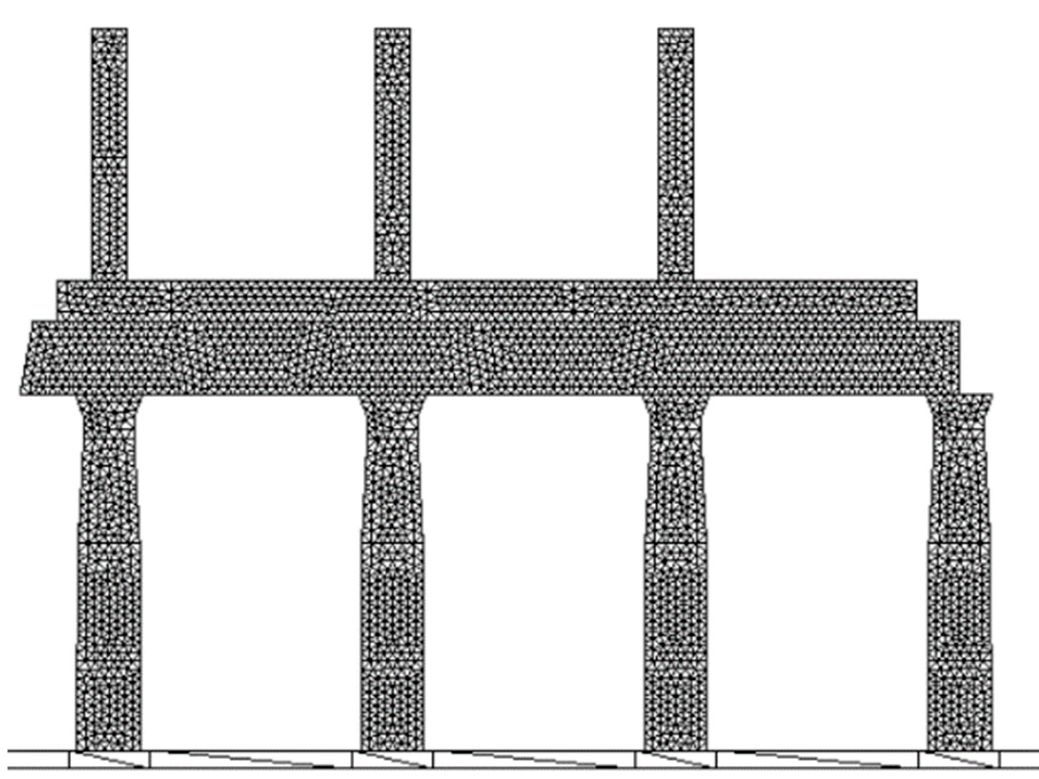
Figure 13. Refined FDEM mesh of the Pompeii colonnade.